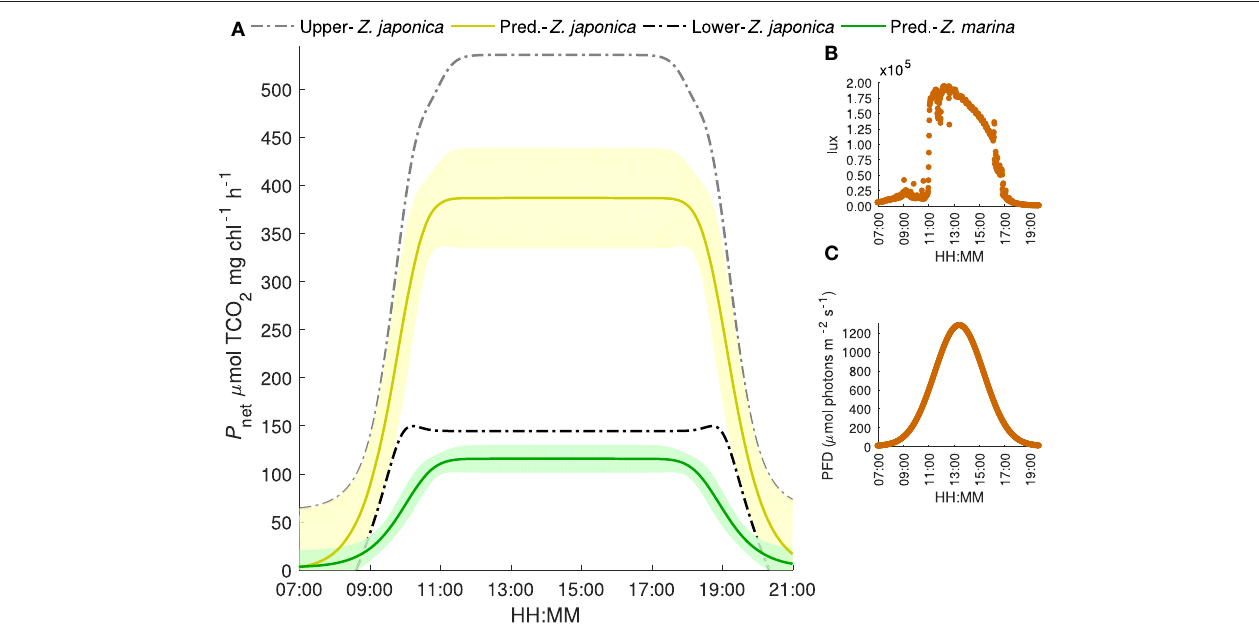
FIGURE 4 | (A) Predicted TCO 2 -irradiance model results of net photosynthetic rates for Z. japonica (yellow line) and Z. marina (green line) under a generalized light cycle from Padilla Bay and mean initial TCO 2 concentration of 1964 µ mol kg − 1 corresponding to the median 400 p CO 2 treatment. Shaded region is the 95% CI. Upper (gray) and lower (black) bounds are the predicted net photosynthetic rate of Z. japonica at initial TCO 2 concentrations of 2051 and 1770 µ mol kg − 1 , respectively. (B) Average lux readings from two HOBO light data loggers deployed at field sample site. (C) Gaussian model fit of the Padilla bay irradiance converted to photon flux density: i.e., a generalized light